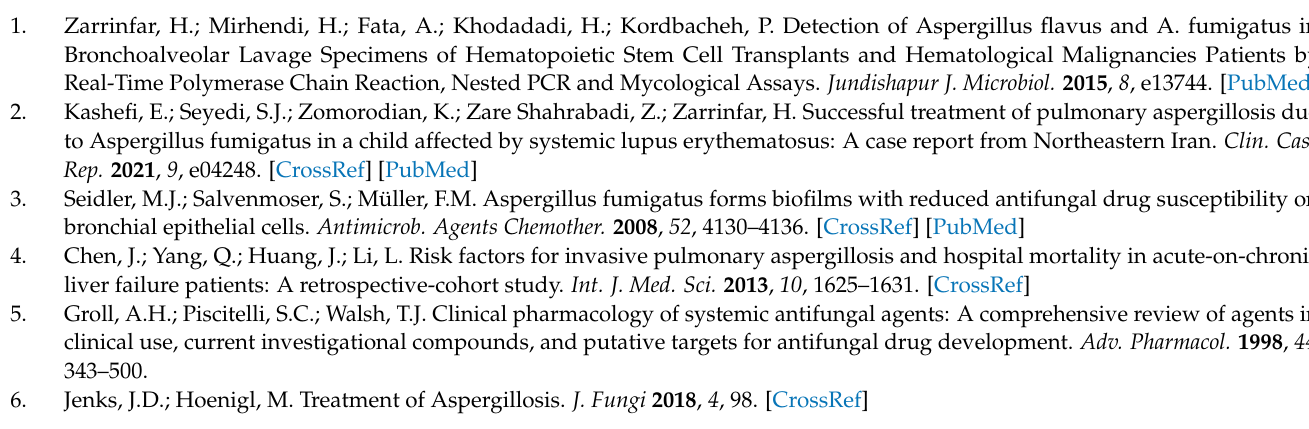
Figure S2: Zeta potential of